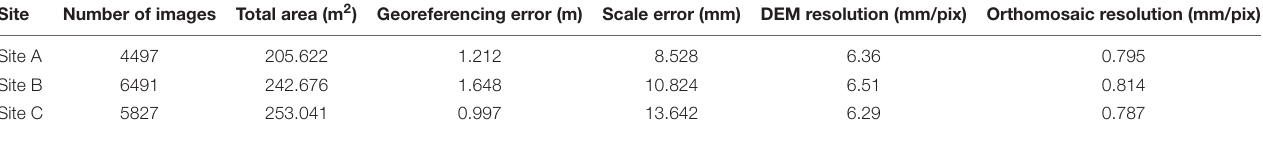
TABLE 1 | Meta-data of the 3D